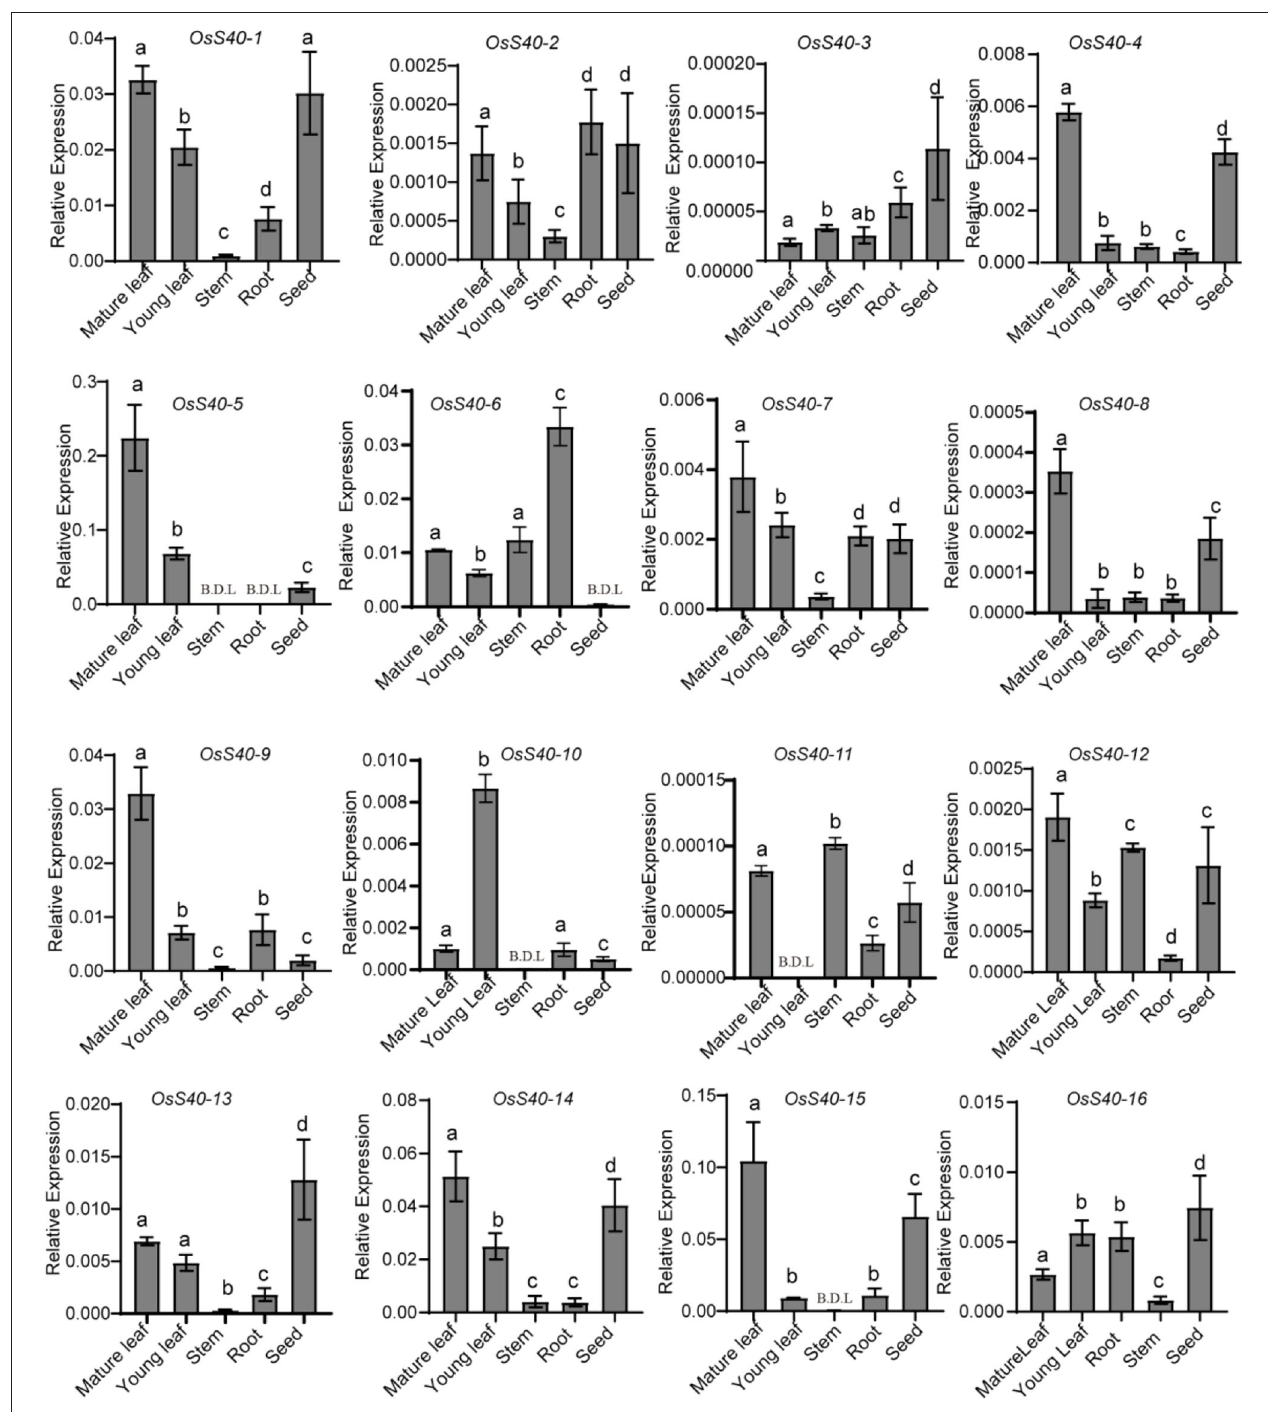
FIGURE 1 | Tissue-specific expression of the OsS40 gene family in rice. Transcript levels are expressed relative to rice OsACTIN in each sample, and values are mean ± SD. Mean and SD values were obtained from three biological replicates and three technical replicates. Statistically significant difference was determined using a one-way ANOVA test ( p < 0.05). Groups carrying the same letter show no significant difference, while a significant difference is found between groups carrying the different letters of a, b, c, or d. B.D.L., below the detection limit.